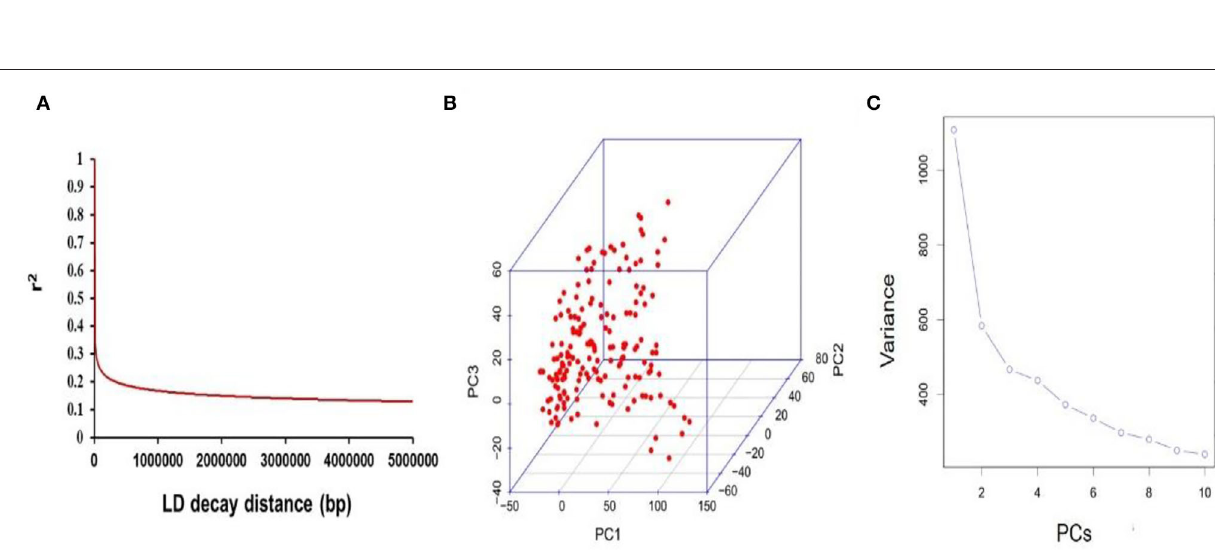
Frontiers in Plant Science |